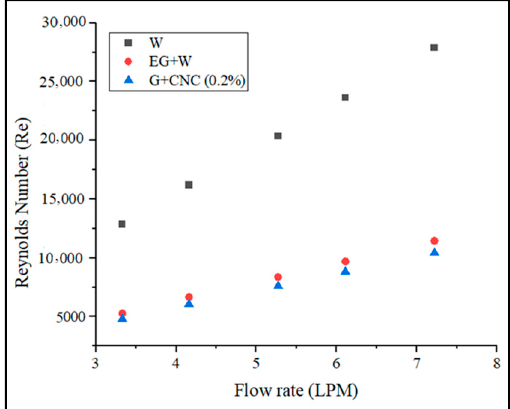
Figure 8. Reynolds number vs. flow rate in LPM.